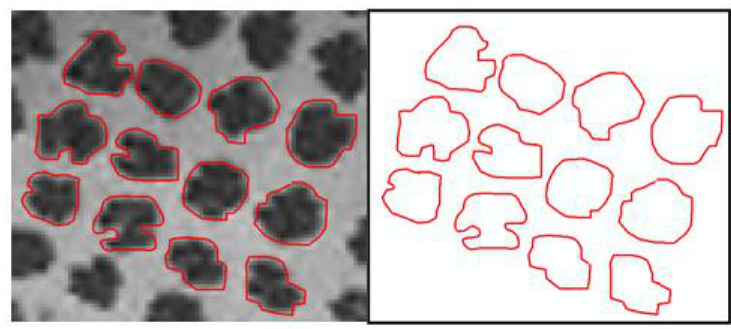
Figure 5. Example of differences in the morphology of the olive crowns.